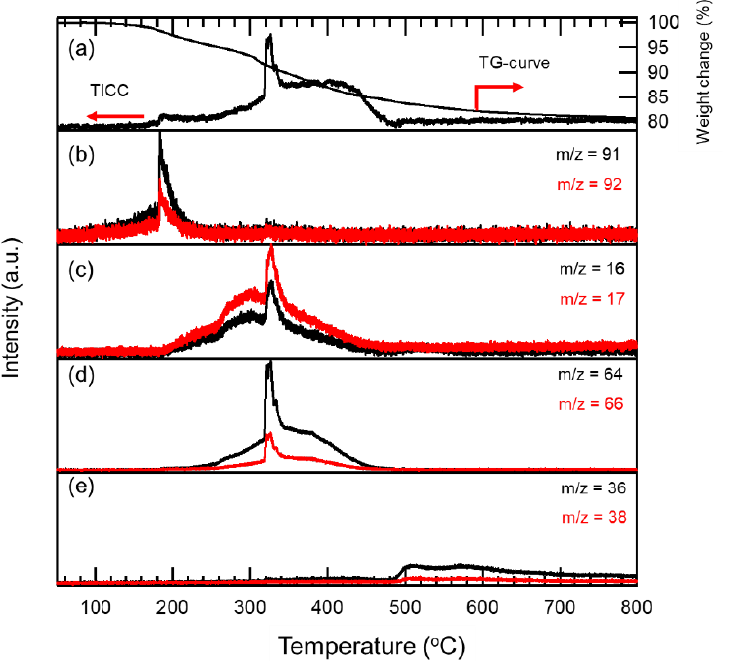
Figure 2. TG-MS analysis under flowing He of the 0.05NiPHPS sample: ( a ) TG-curve coupled with the total ion current chromatogram (TICC), ( b – e ) the simultaneous monitoring of gaseous products formed in situ . Table 1. Chemical composition of pyrolyzed samples.